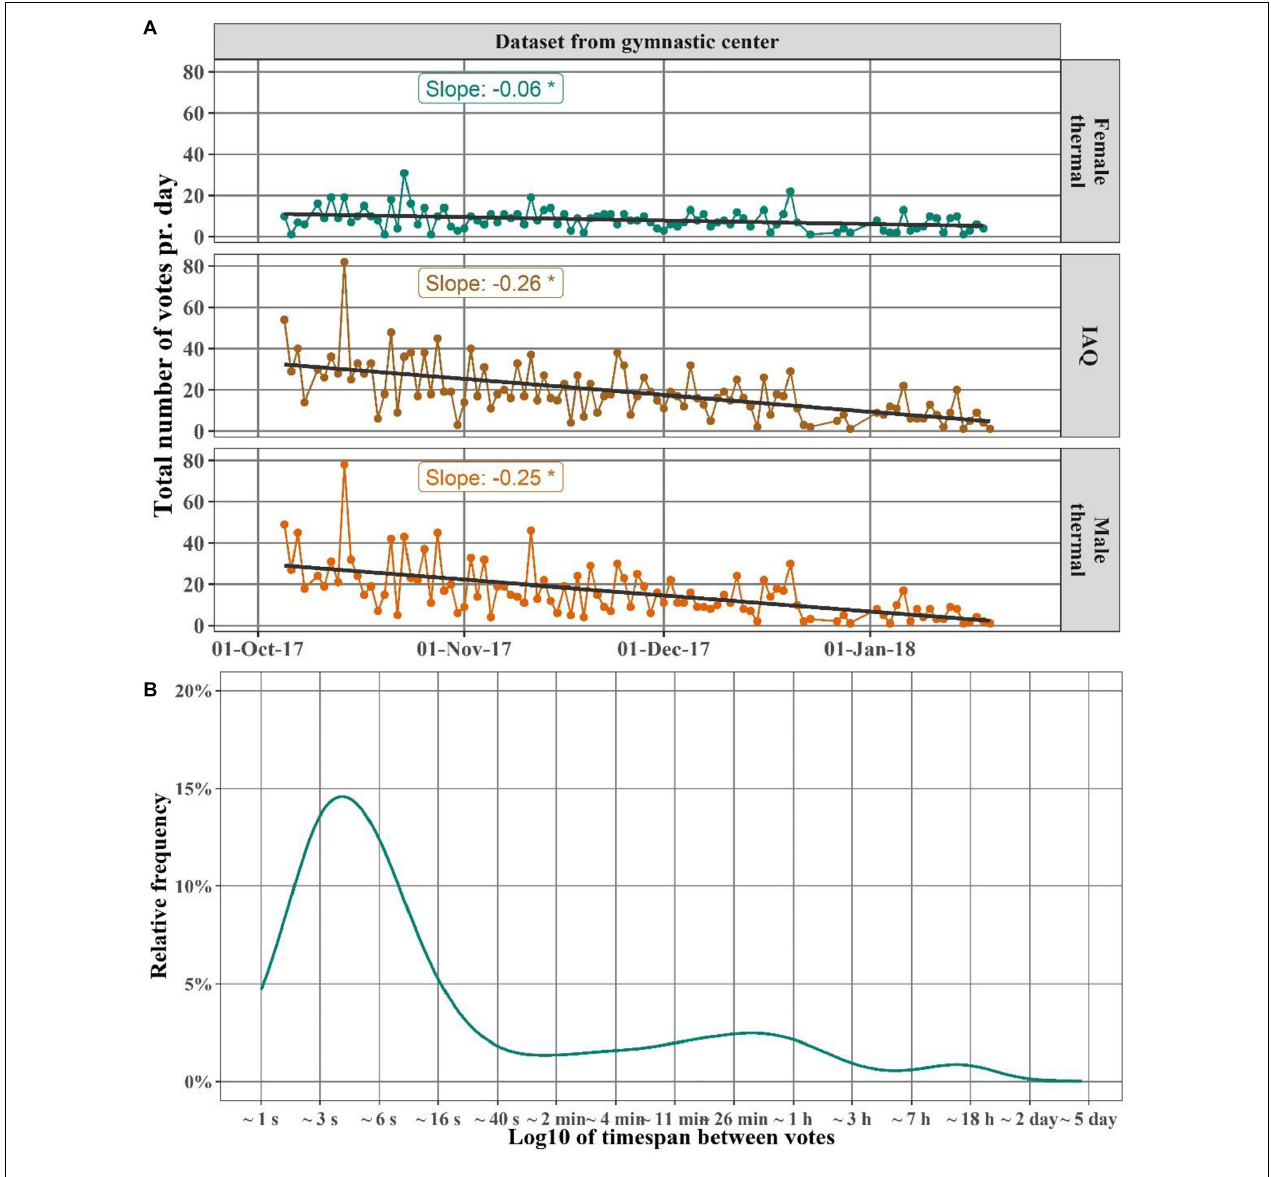
FIGURE 13 | The dataset from Berquist et al. (2019) of votes from three panels located at an entrance to a gymnastic centre in Ontario. (A) The total number of votes per day. The value and significance (denoted with * if p -value < 0.05) of the slope are displayed for the trend lines. (B) Relative frequency of the common logarithm of timespan between two votes. The density plot had a bandwidth of 0.2